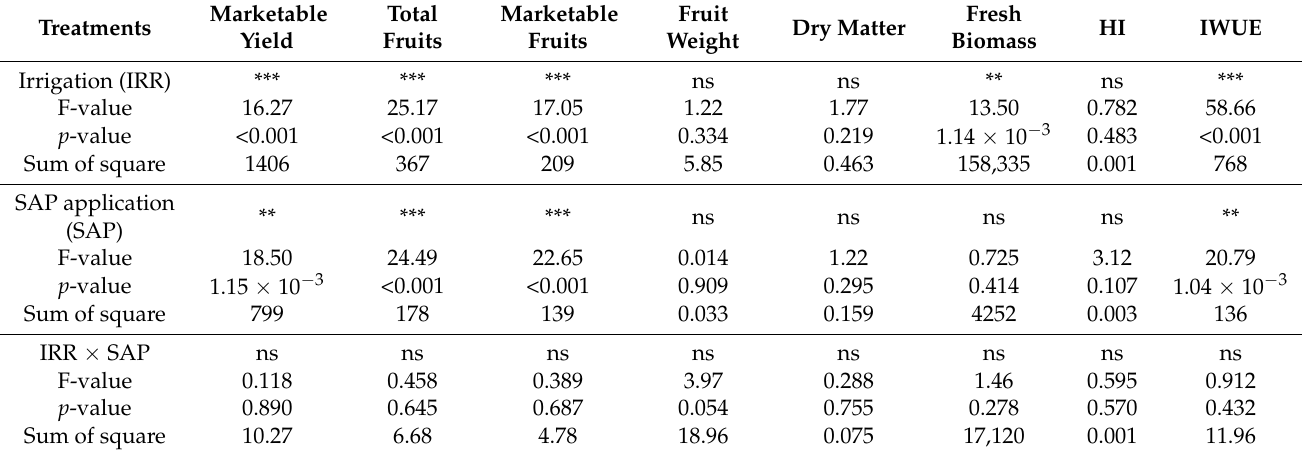
Table 1. Results of two-way ANOVA analysis on yield component and morphological parameters of processing tomato grown under different irrigation treatments (IRR) factorially combined with the application of two levels of a superabsorbent polymer (SAP-treated and non-treated control). Interaction results are also described (IRR ×